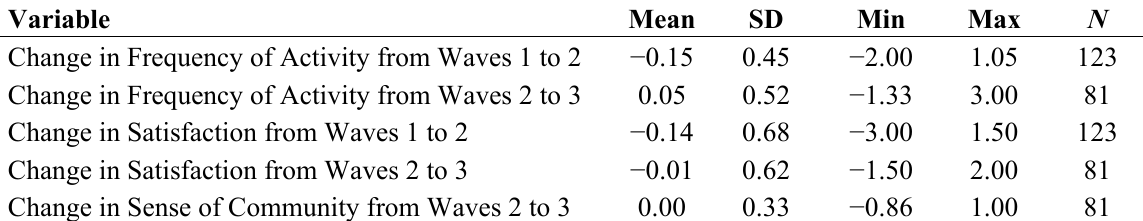
Table 6. Summary statistics of change in survey responses over waves 1, 2, and